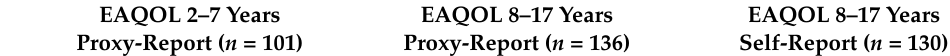
Table 1. Basic characteristics of the respondents, presented as n (%) or median (interquartile range). ISCED = International Classification of Education, EA = esophageal atresia, VACTERL = vertebral, anorectal, cardiac, tracheoesophageal, renal, or limb anomalies, ISCED = International Classification of Education [26]. A City with >100,000 citizens. B At time of filling out questionnaire. C Birth weight <10th percentile [29]. D According to Gross classification [27]. E According to Solomon criteria